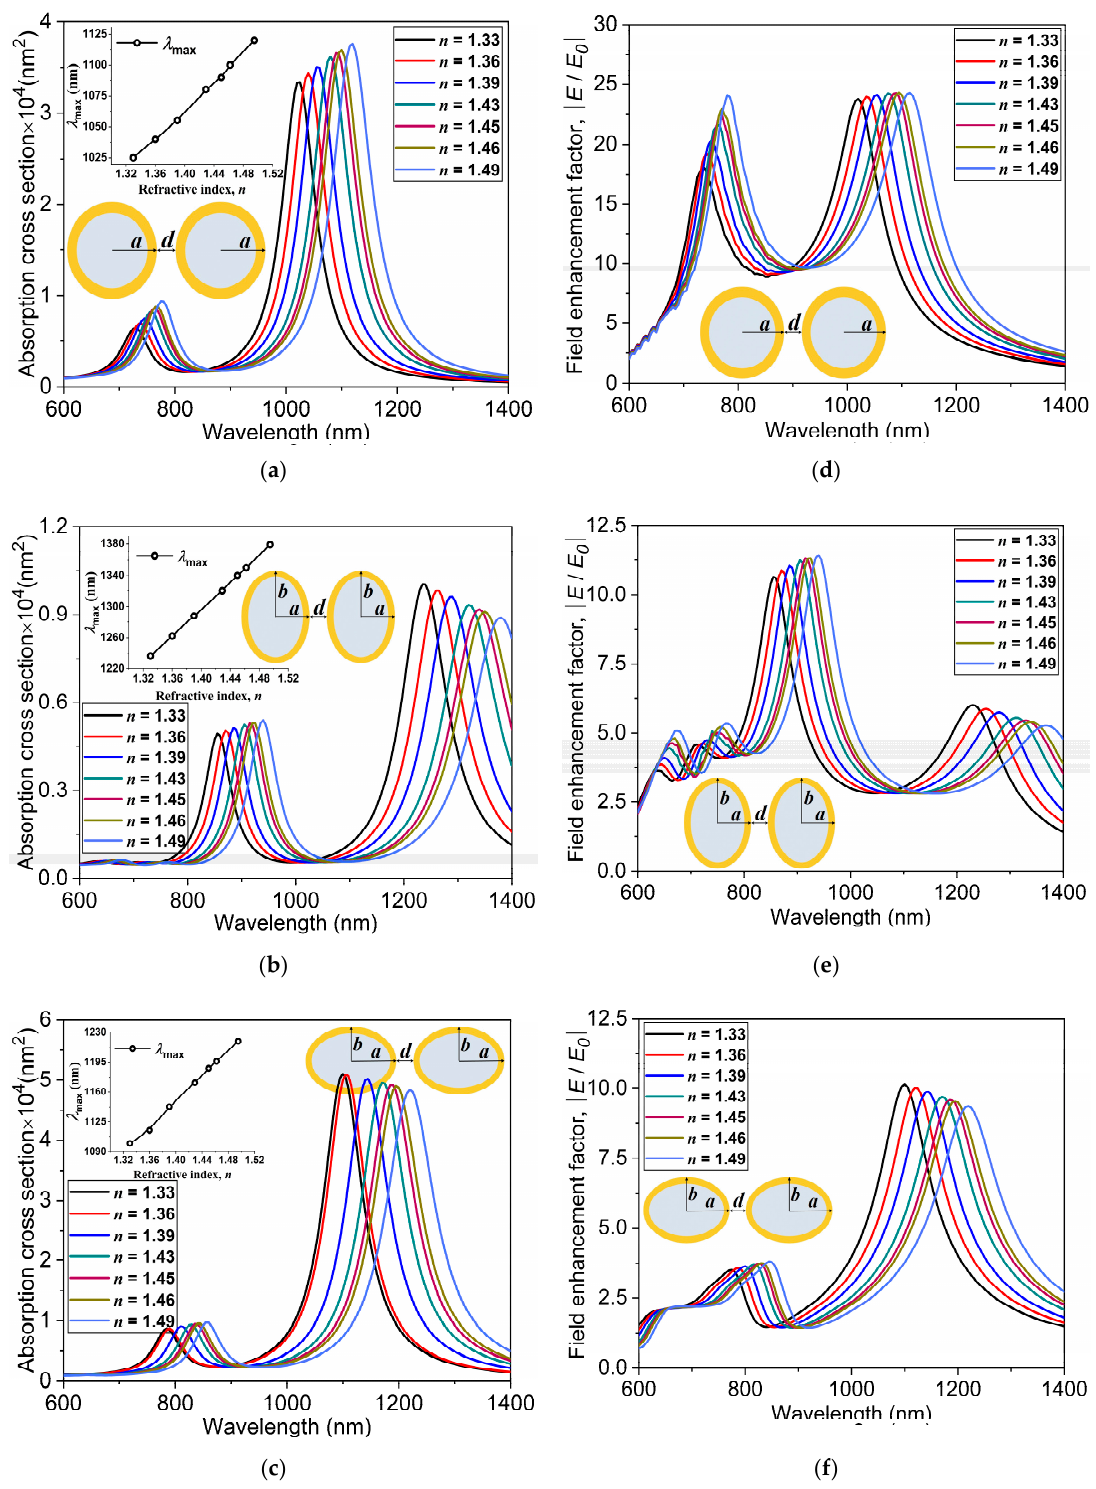
Figure 5. Absorption cross-sections at different refractive indices of the surrounding medium for the ( a ) spherical (𝑟 = 20 nm,𝑡 (cid:2885)(cid:2931) = 3 nm) , ( b ) prolate and ( c ) oblate core-shell nanostructures (𝑟 (cid:2915)(cid:2916)(cid:2916) = 23 nm,𝜂 = 3) . The insets in panels ( a – c ) show the dependence of the LSPR peak positions ( λ max ) on the refractive index. The electric field enhancement | E / E | at different refractive indices for the ( d ) spherical, ( e ) prolate, and ( f ) oblate core-shell 0